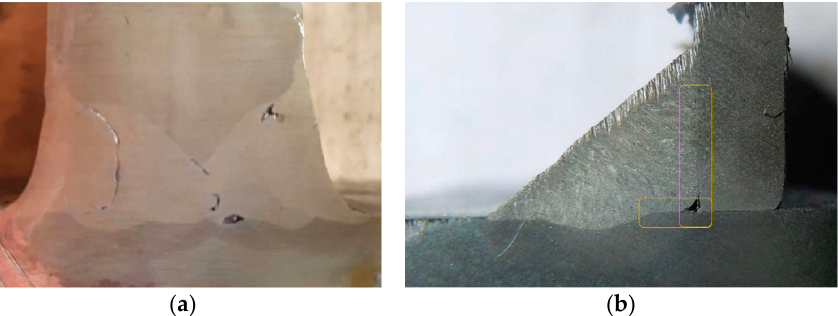
Figure 7. ( a ) Lack of fusion due to improper handling of the gun, applying the arc heat unevenly; ( b ) incomplete fusion as a result of the weld pool being ahead of the electric arc, preventing proper fusion.